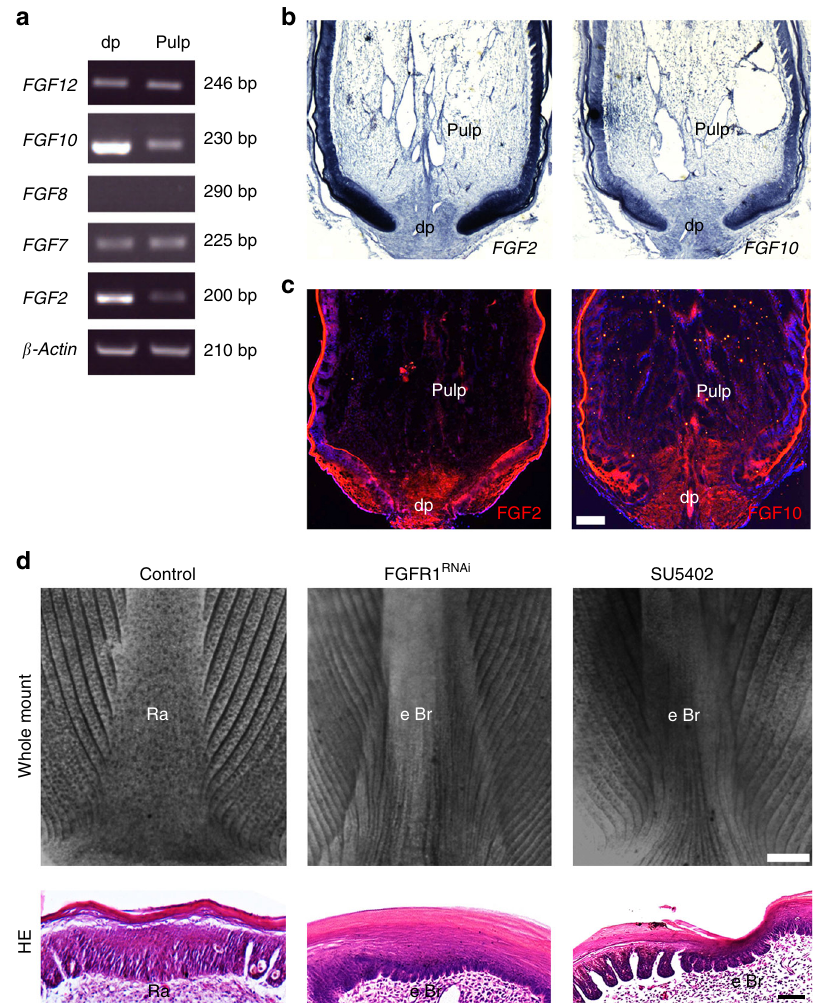
Fig. 6 A proximal-distal FGF signaling gradient regulates feather branching. a Semi-quantitative RT-PCR analysis revealed graded expression of FGF10 and FGF2 in the feather follicle. The dermal papillae (dp) and the pulp represent the proximal and distal compartment of the follicle, respectively. b In situ hybridization and c immuno fl uorescence showing the graded expression of FGF2 and FGF10 in the feather follicle. d Whole mount view and HE sections of the feather rachis after manipulating the FGF signaling via RNAi- FGFR1 lentivirus local injection, or SU5402 (100 μ M) chemical inhibitor treatment in vivo. Ectopic branches were induced by both treatments. Representative images from fi ve repeated experiments are shown. Ra rachis, eBr ectopic branch. Bar